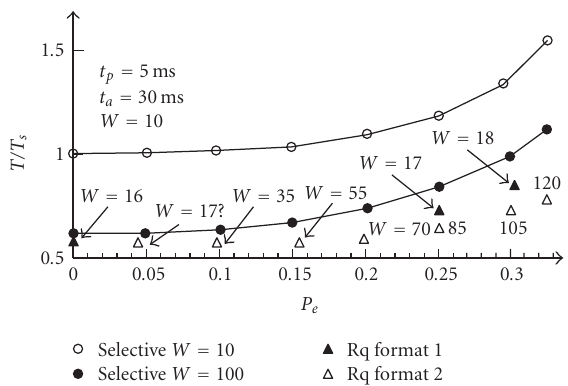
Figure 10: Our scheme versus selective acknowledgments with fixed window size (analytical